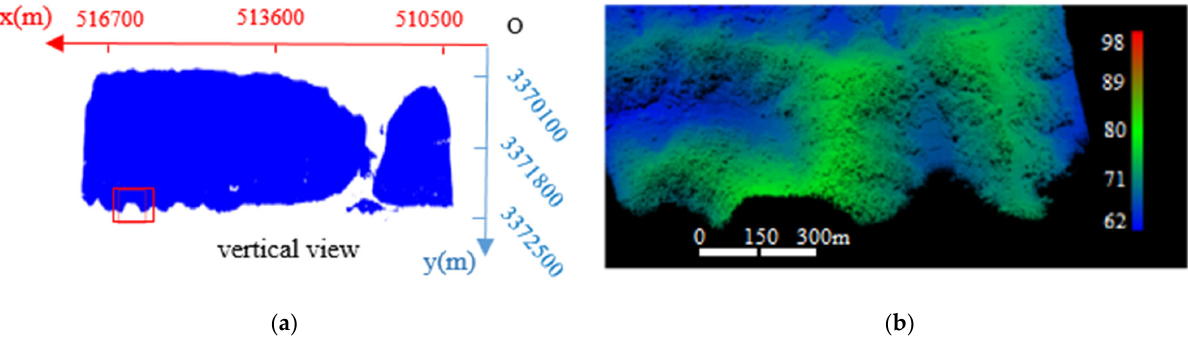
Figure 1. ( a ) The image of point cloud in original sea area; ( b ) the image of point cloud in cliff area. Three concepts are defined here. (1) Connection points. The outer line of the point cloud in the sea area, which includes the cliff section, is the process of passing through the outer line of the normal ground, then passing through the transition point to the outer line of the cliff section, and then passing through the transition point on the other side to return to the outer line of the normal ground. These two transition points, the two points connecting the outer line of the ordinary ground and the outer line of the cliff section, are called “connection points”. (2) Depth points. From the outer line of the cliff section, the ground of the cliff section will be lowered from the water body side to the land side (in this case, the ground of the cliff section will be lowered from the land side to the water body side, which is almost non-existent in practice). When the ground elevation is lowered to approximately the same height as the water body, the ground at this time is considered as the last position of the cliff section. This position can be divided by a line, which is imaginary in the data. However, the ground of the cliff section will decrease from the water body side to the land side; that is, the elevation of the ground will decrease. The ground is lowered to approximately the same height as the water body; that is, the elevation of the ground is close to the elevation of the two connection points. Therefore, the point with the smallest difference between the two connection points in the x, y plane direction and the z elevation direction can be found in the cliff section area data, and these two points are called “depth points”. (3) Side points. The point cloud of the cliff segment is segmented at fixed intervals according to the x-coordinate (x-coordinate when the main coastline is east-west or west-east, and y-coordinate when the main coastline is north-south or south-north). Each segment is called a point-cloud block, and the centroid coordinates of each point-cloud block are calculated. Each block can be imagined as a rectangle. Take the coastline whose main trend is along the x-axis as an example; the short side of the rectangle (that is, the block spacing) is parallel to the x-axis, and the long side is parallel to the y-axis. Only the x and y coordinates of the point cloud in the block are considered. It can be imagined that the plane coordinates of these points are all within the rectangle. Then, the parallel line to the short side of the rectangle is made through the plane coordinates of the centroid point of the block. Then, the line is parallel to the short side and also parallel